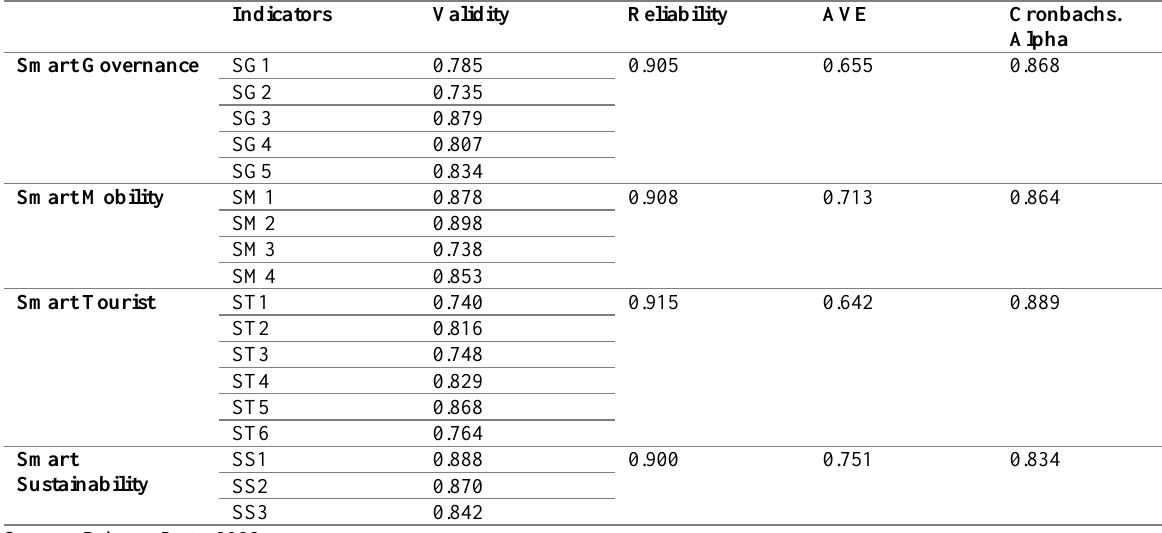
Table 2: Convergent Validity, Construct Reliability, AVE, Cronbach’s